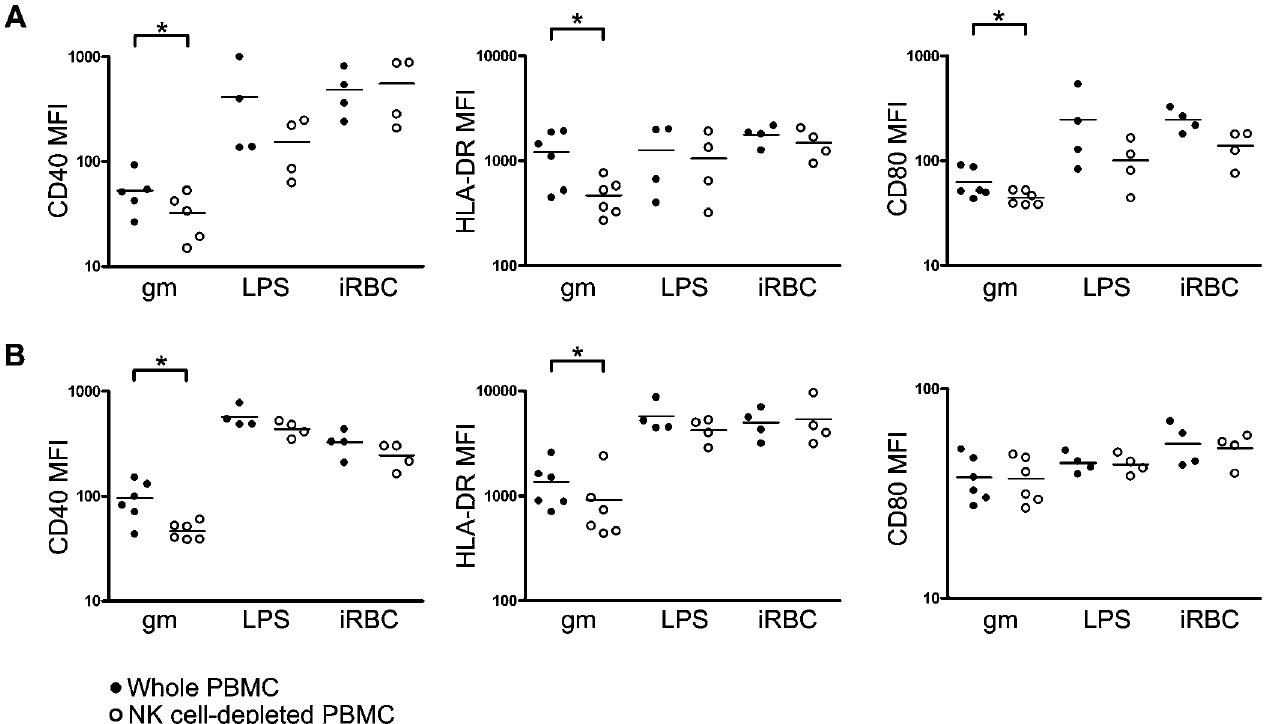
Figure 7. NK Cells Are Required to Maintain Maturation Status of Accessory Cells Whole PBMCs (closed circles) or NK cell–depleted PBMCs (open circles) were cultured alone or with E. coli LPS or iRBCs for 24 h. The MFIs of CD40, HLA- DR, and CD80 surface staining on (A) monocytes and (B) mDCs were determined by flow cytometric analysis. *, p , 0.05; p -values are for paired t tests comparing whole PBMCs with NK cell–depleted PBMCs from the same donor.